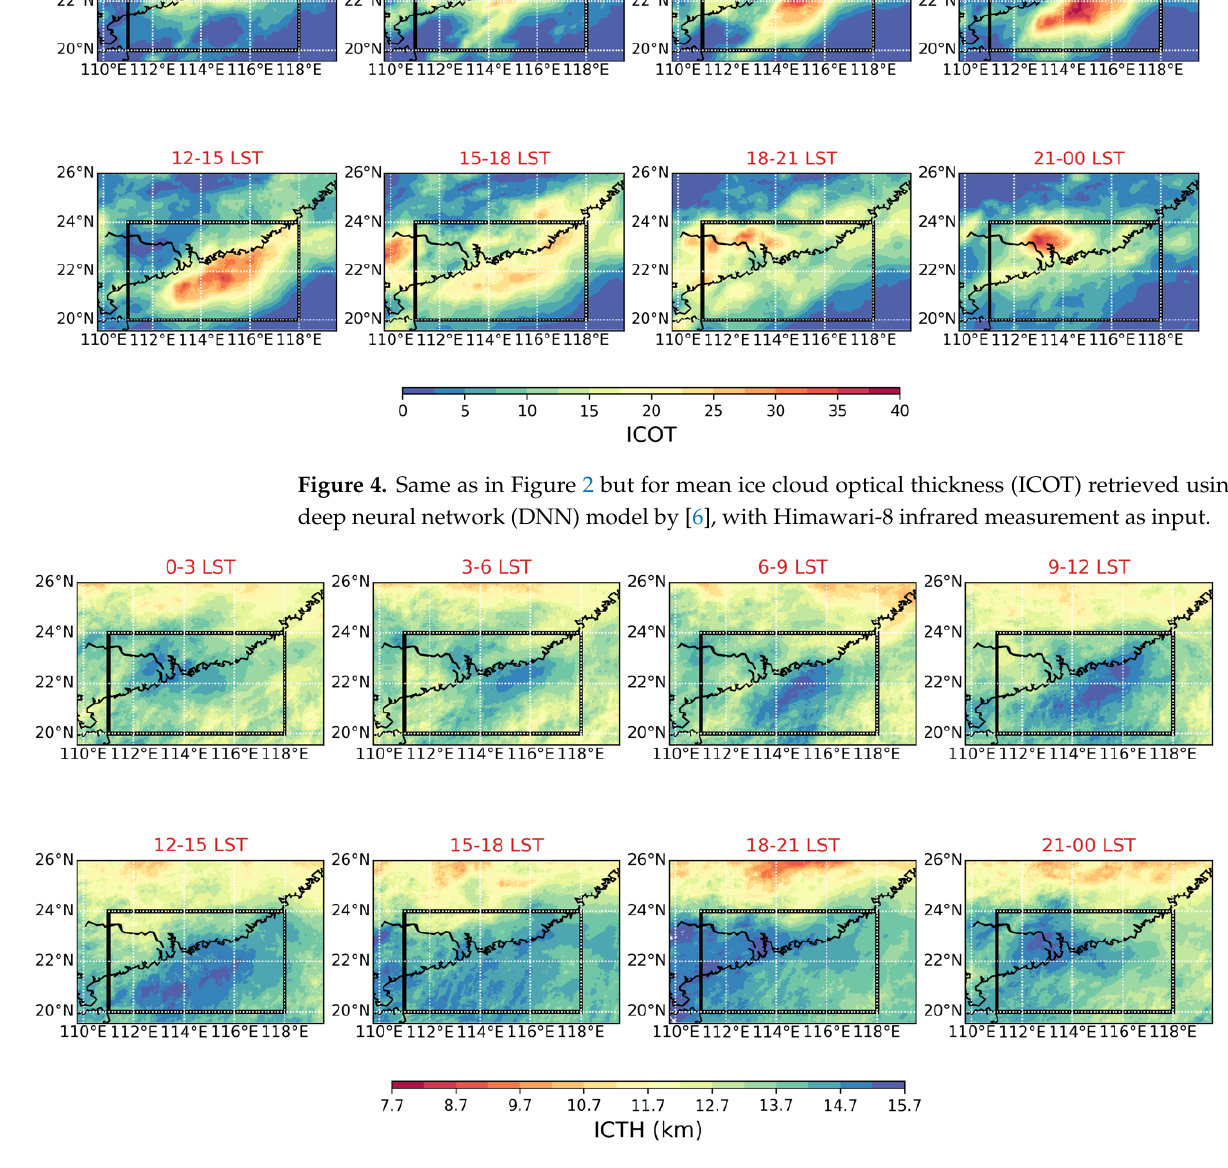
Figure 5. Same as in Figure 2 but for mean ice cloud top height (ICTH) retrieved using the DNN model, with Himawari-8 infrared measurement as input.